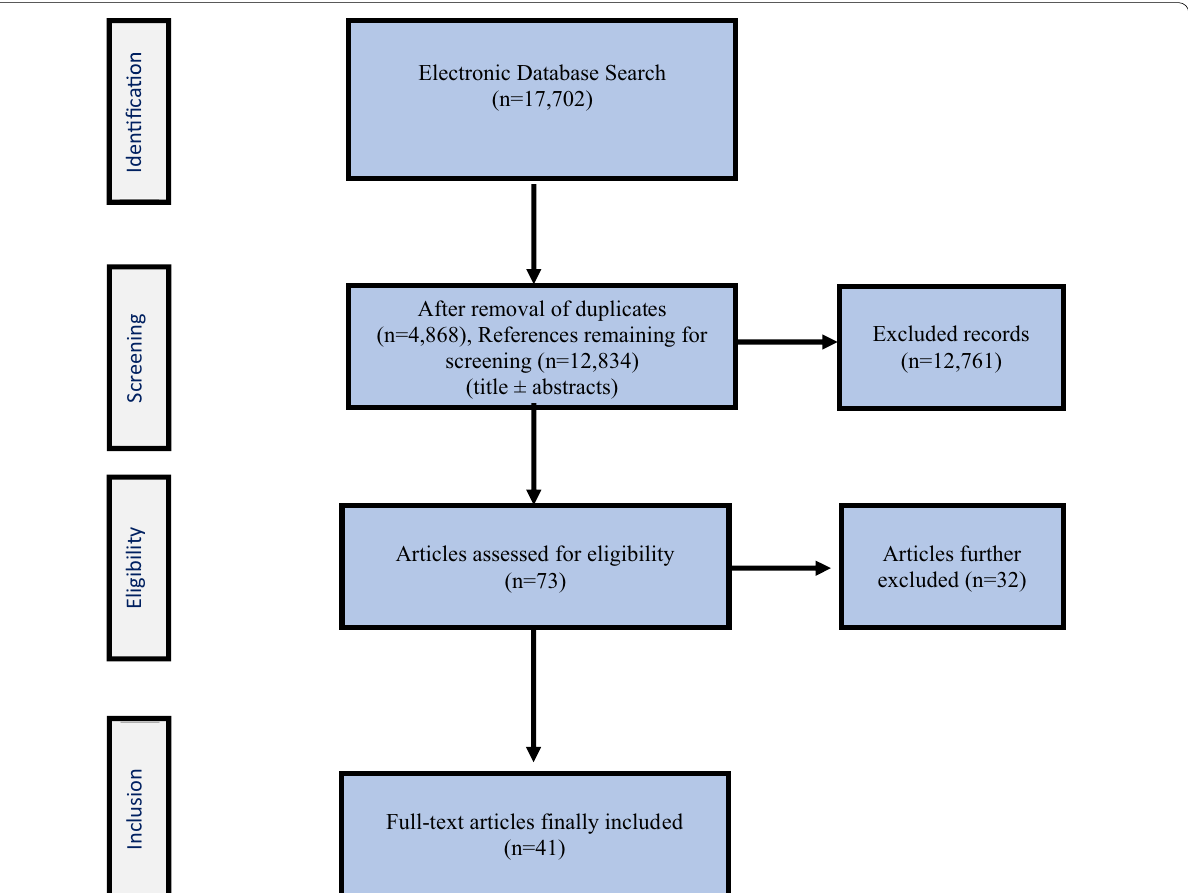
Fig. 1 PRISMA flow diagram presenting the methodological approach for identification, screening, eligibility, and final inclusion of relevant